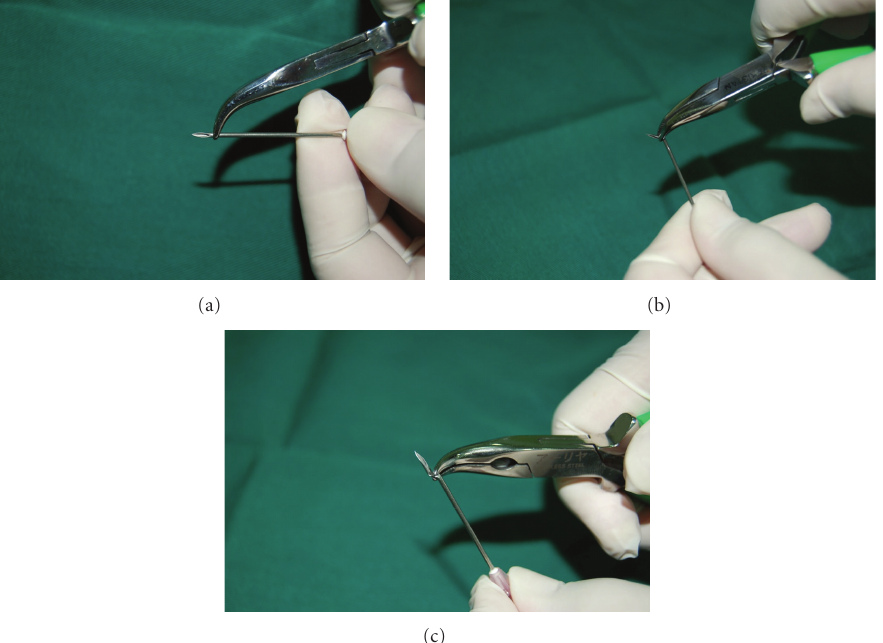
Figure 1: (a) The tip of the plier is positioned just proximal to the bevel of the needle. (b) The needle is bent with an upward motion till it reaches 90-degrees, creating the first angle. (c) The tip of the plier is moved 1-2mm proximal to the first angle and a second 90-degree angle is created opposite to the direction of the first angle.